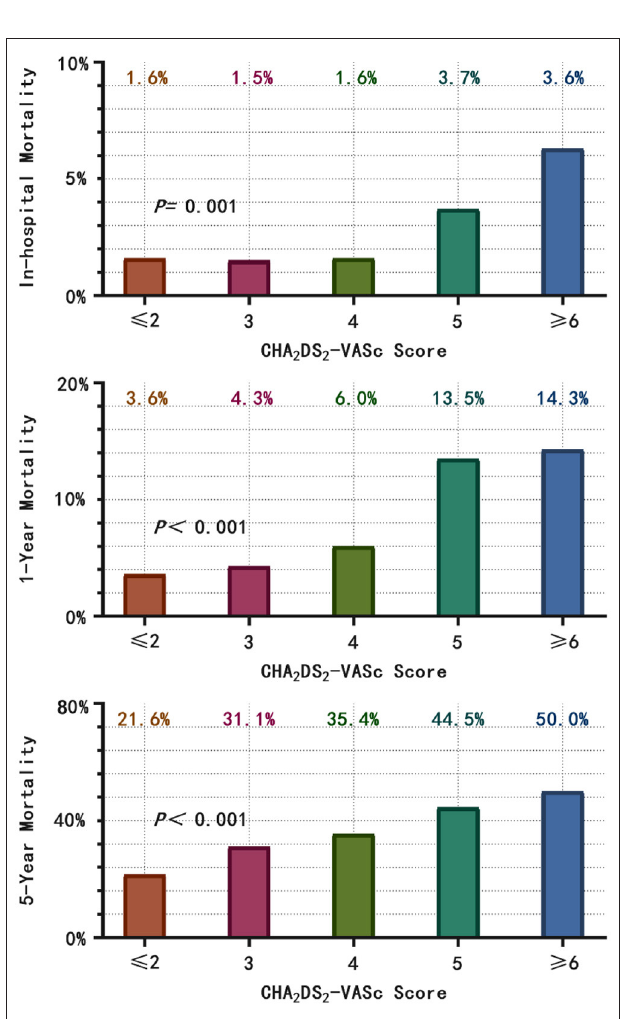
FIGURE 2 | According to the CHA 2 DS 2 -VASc score category, the in-hospital, 1- and 5-year all-cause mortality were calculated. With the increase in CHA 2 DS 2 -VASc score, the in-hospital, 1- and 5-year all-cause mortality